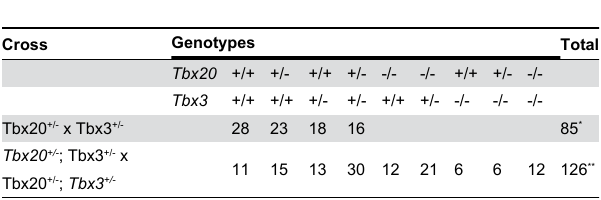
Cross Genotypes Total